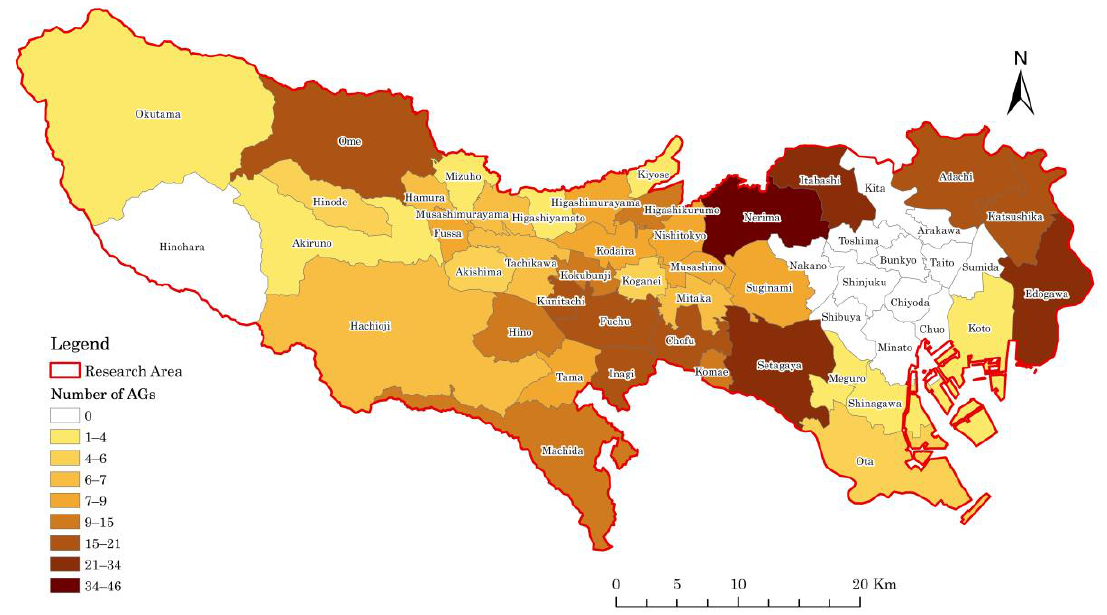
Figure 5. Quantitative distribution characteristics in municipalities. The municipalities’ names are abbreviated by removing “ ku ” , “ shi ” , and “ machi ” .